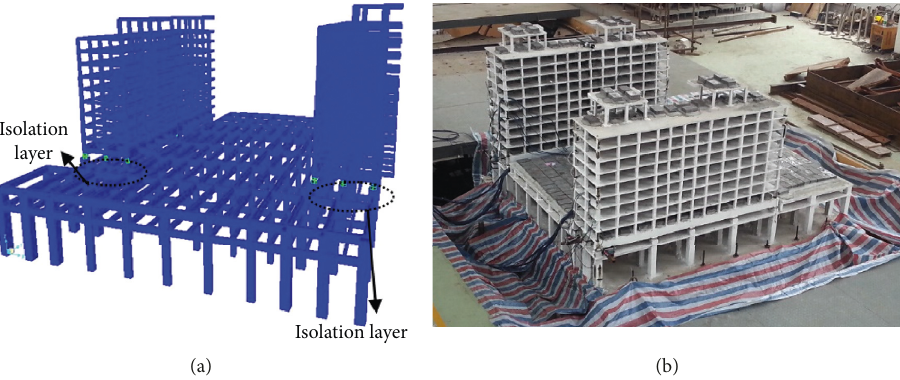
Figure 12: Shake table test with isolated building. (a) Numerical model; (b) test